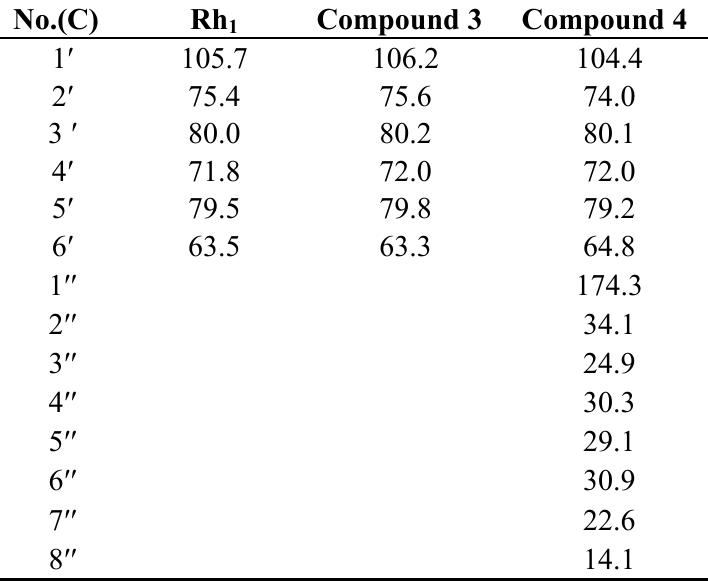
Table 2. 13 C-NMR data of sugar and fatty acid ester moieties of compound 3 and 4